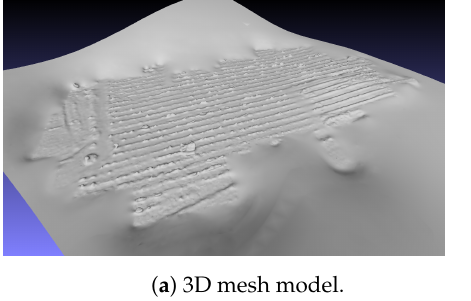
Figure 17. Reconstructed models of the surveyed area.